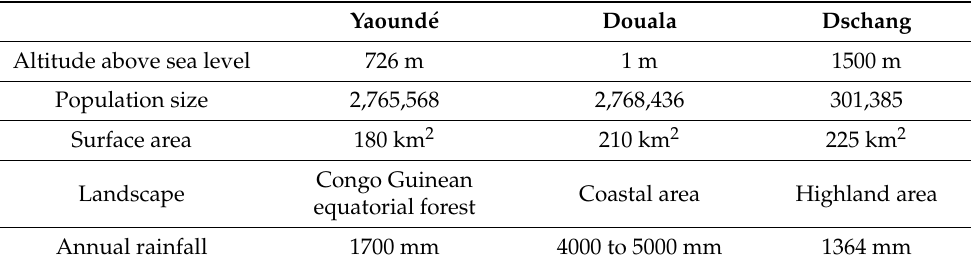
Figure 1. Localization of the study sites in Cameroon. Table 1. Characteristics of the three study